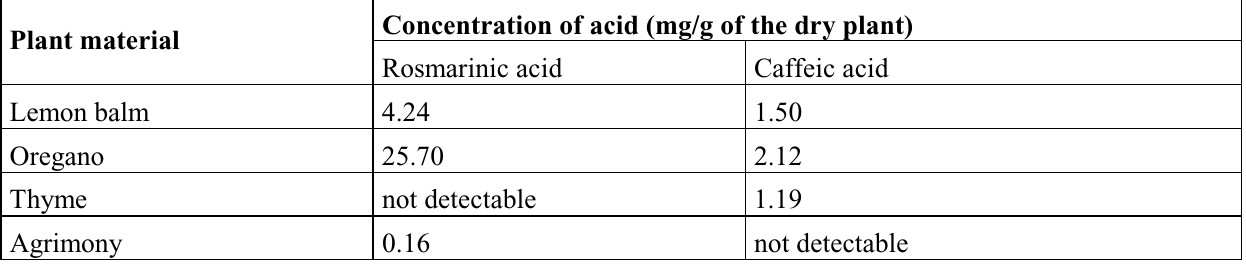
Table 1. HPLC determination of the phenolic acids in the aqueous plant extracts (2g dry plant /100ml).